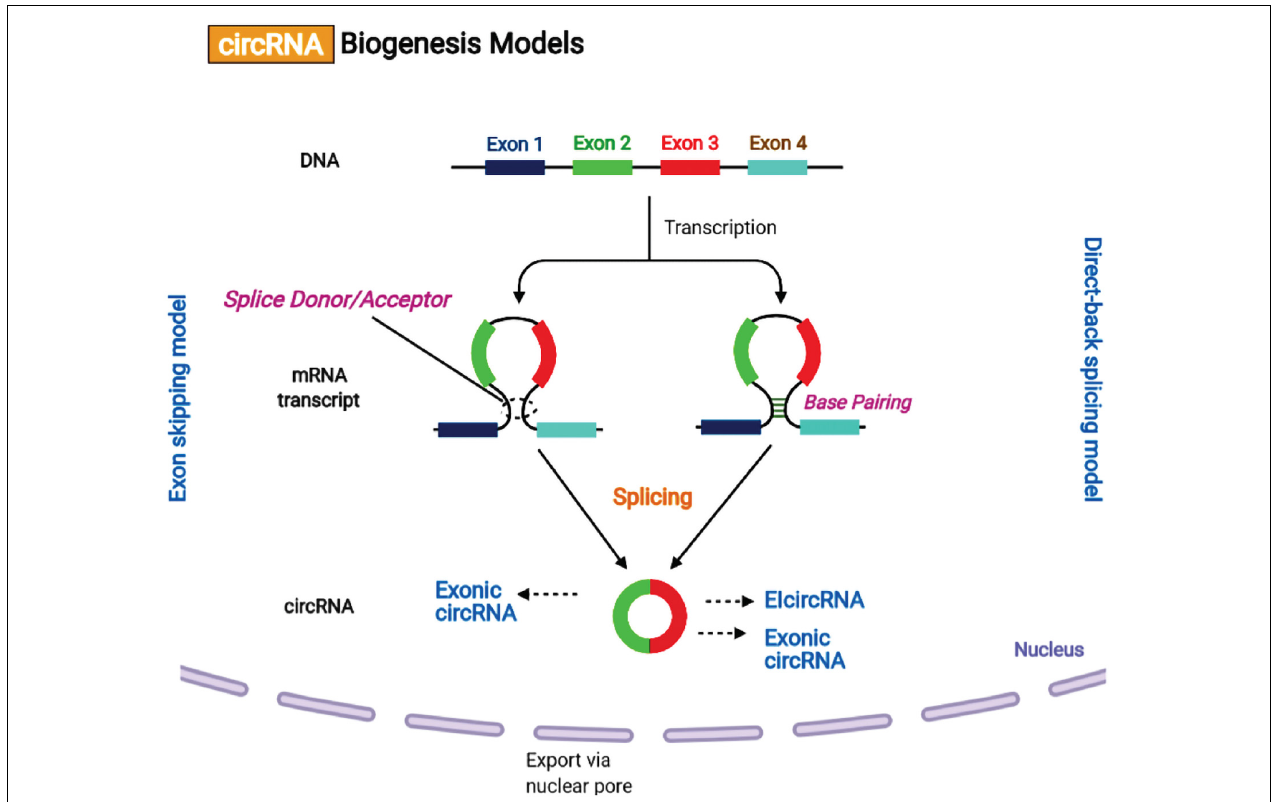
FIGURE 4 | Circular RNA biogenesis mechanisms. (A) Lariat-driven circularization or exon skipping model. The splice donor at the 3 (cid:48) end of Exon 1 is covalently attached to the splice acceptor at the 5 (cid:48) end of Exon 4 creating a lariat via exon skipping. Then, the spliceosome removes the introns for creating a circular RNA. (B) Intron pairing-driven circularization or direct-back splicing model. The successive introns form a circular structure by base pairing, and then are eliminated for forming an exonic circRNA or re-attached to form an